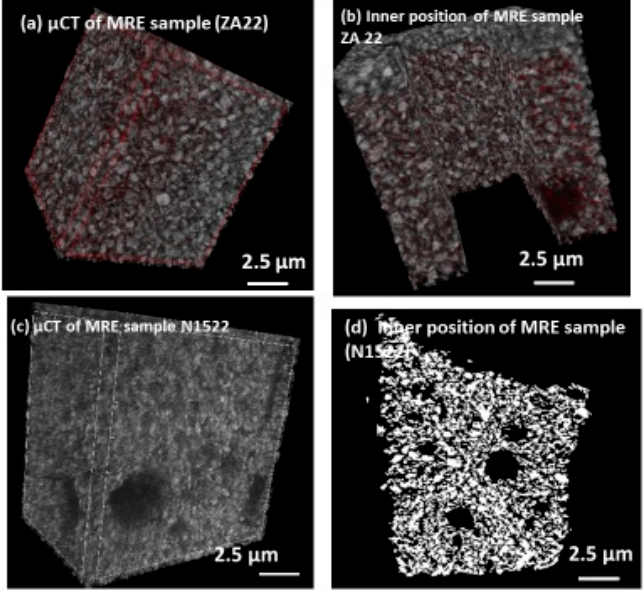
Figure 14. µCT characterization of iron filler MRE composites at different orientation for MREs with matrices ZA 22 ( a , b ) and N1522 ( c , d ).